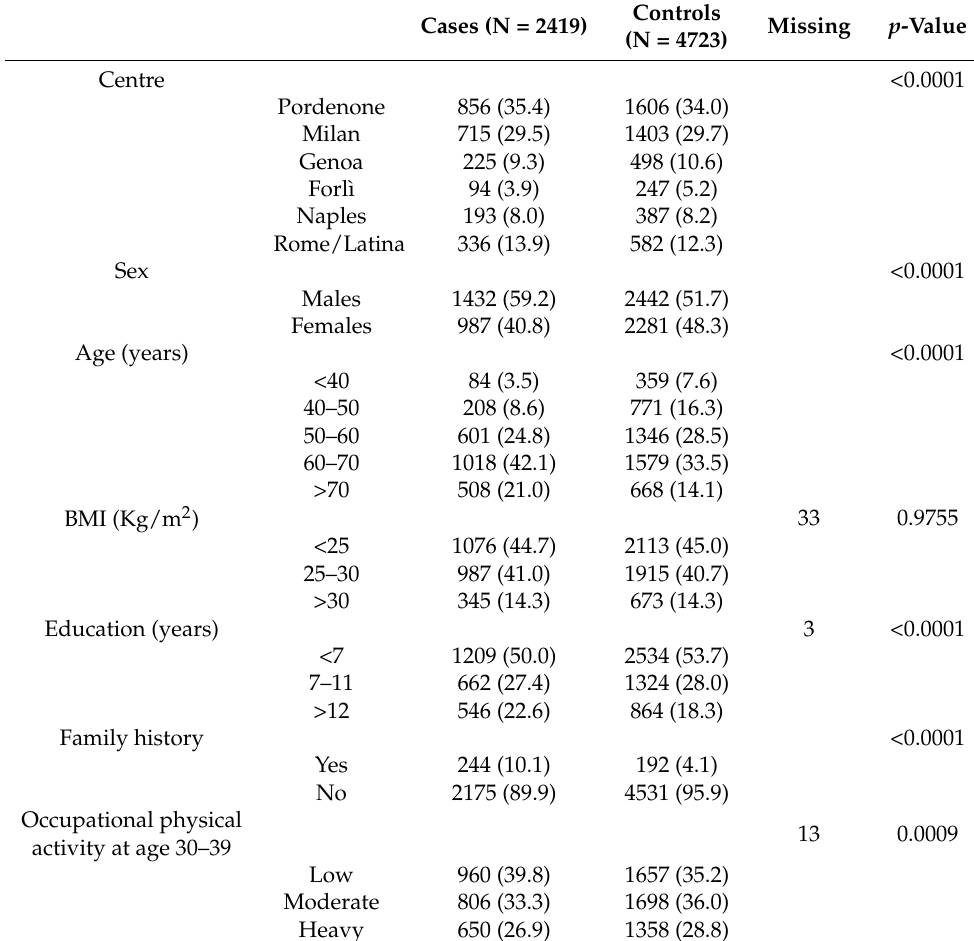
Table 1. Distribution of 2419 colorectal cancer cases and 4273 controls according to selected